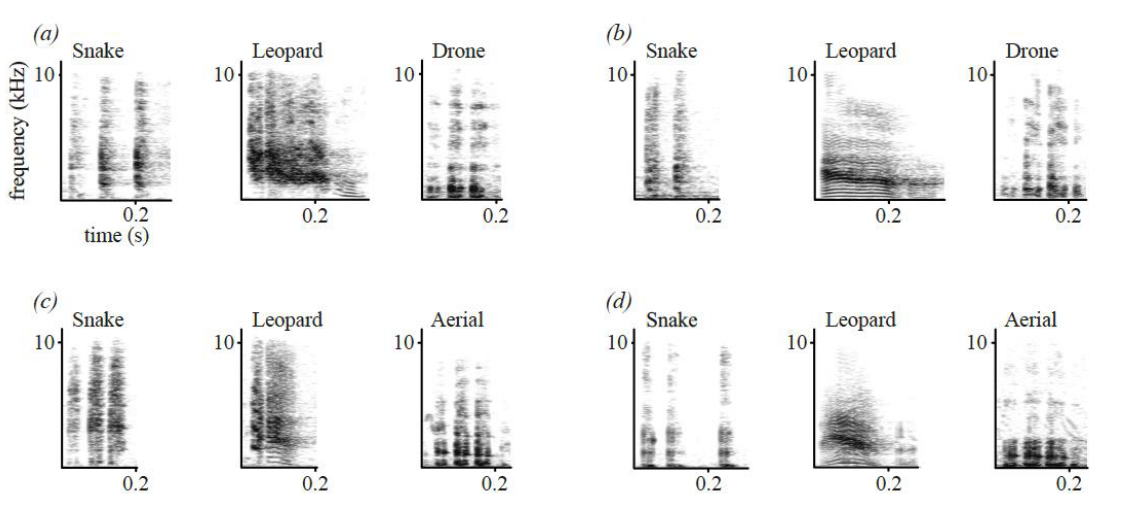
Figure 1. Spectrograms of West African green monkey and East African vervet monkey alarm calls, in response to different predator/threat types. a) Female green monkey calls; b) male green monkey calls; c) female vervet monkey calls; d) male vervet monkey calls (reprinted from Fischer & Hammerschmidt, 2019 with